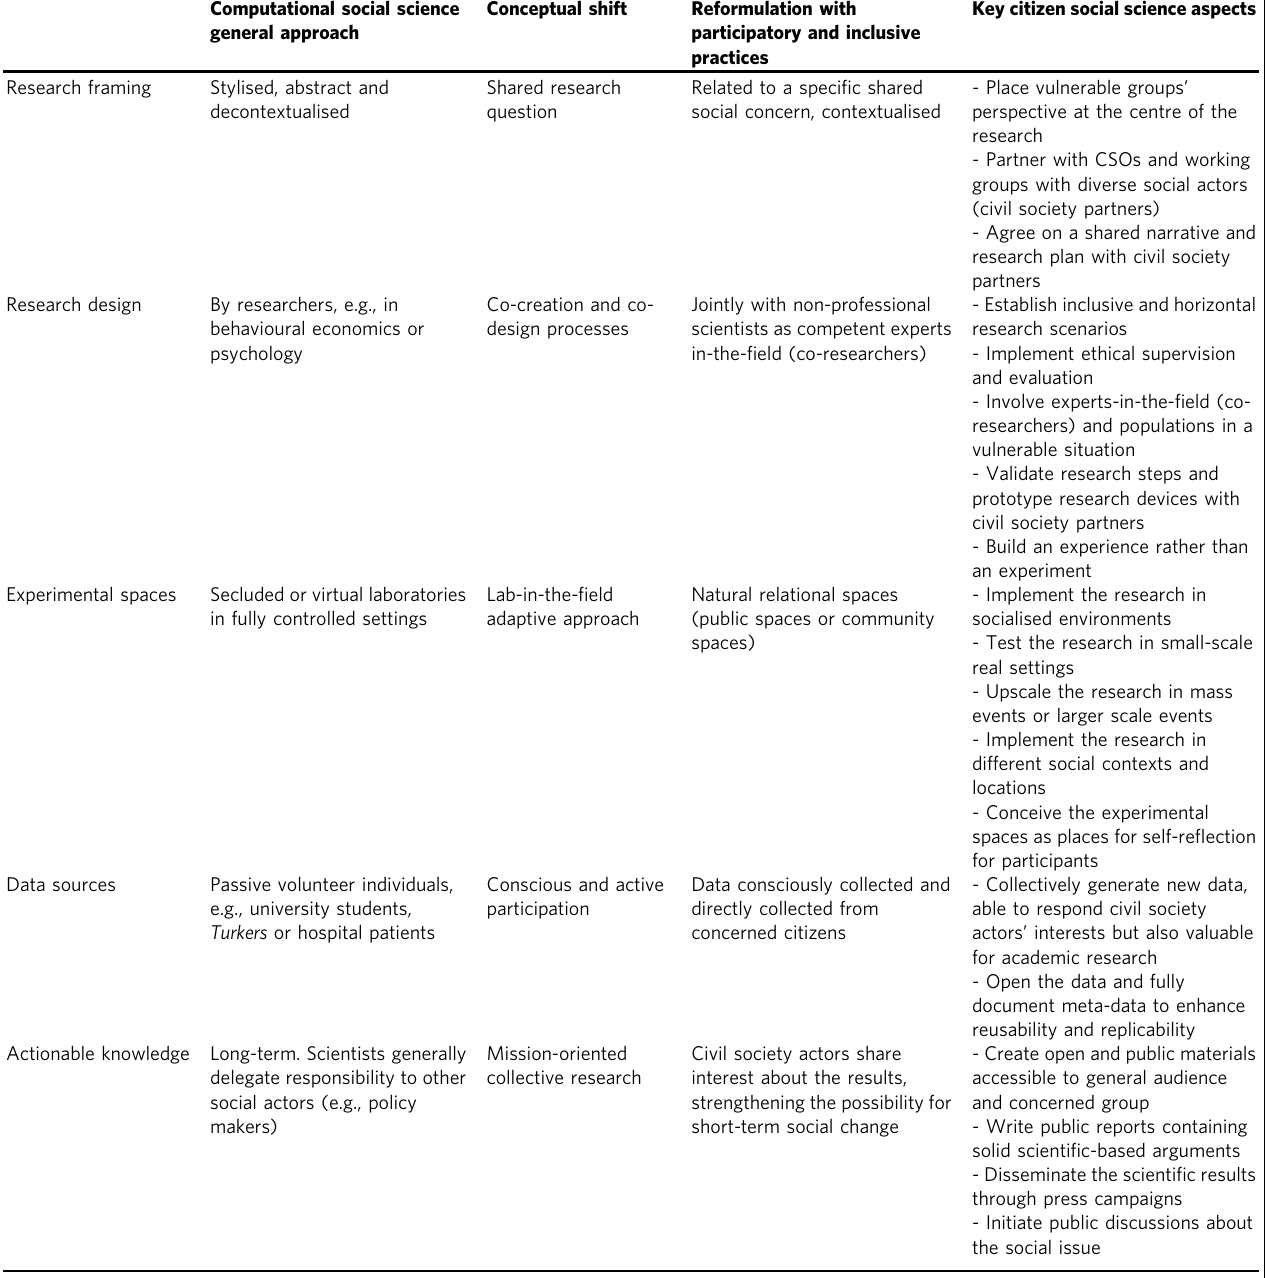
Table 1 Computational social science approach and its reformulation when participatory and inclusive practices are